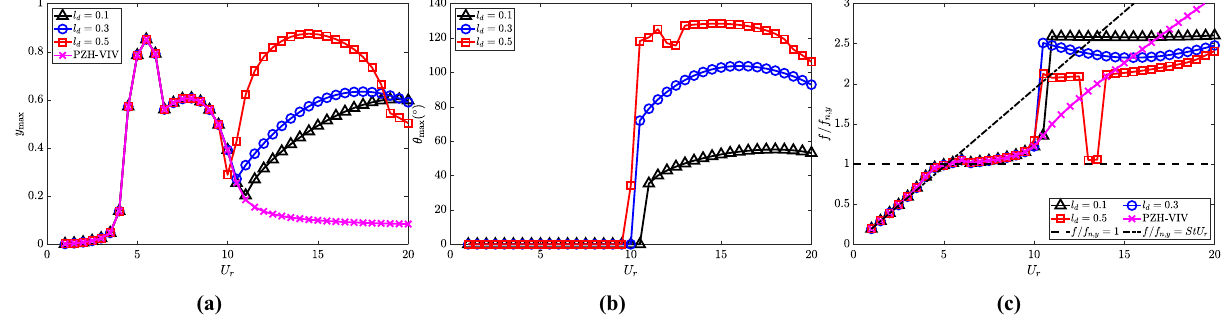
Figure 11. Response characteristics of the system for various l d with U r : ( a ) maximum non-dimensional oscillation amplitude ( y max ) of the cylinder, ( b ) maximum angular rotation of the pendulum θ max in degrees ( ◦ ) and ( c ) dominant frequency with respect to cylinder natural frequency f / f n , y . Here, m = 0.3 , ω r = 1.3 and ζ θ = 0.0011 .